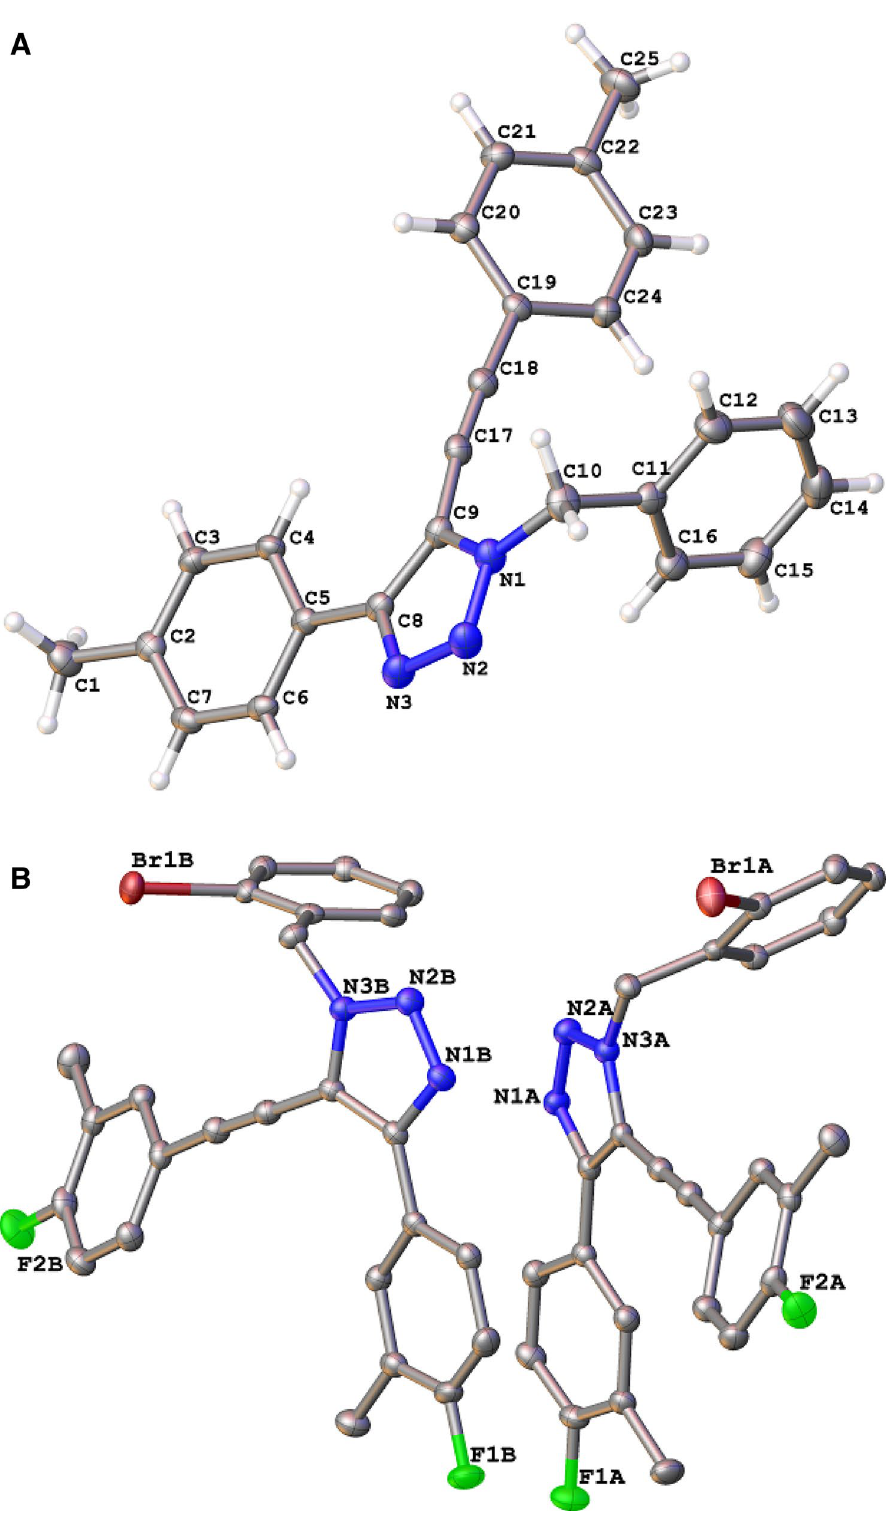
Figure 2. ( A ) The single crystal structure of 1-benzyl-4-(4-methoxyphenyl)-5-((4-methoxyphenyl) ethynyl)- 1 H -1,2,3-triazole, 3ac . ( B ) The single crystal structure of 1-(2-bromobenzyl)-4-(3-fluoro-4-methylphenyl)-5- ((3-fluoro-4-methylphenyl) ethynyl)-1 H -1,2,3-triazole, 3be